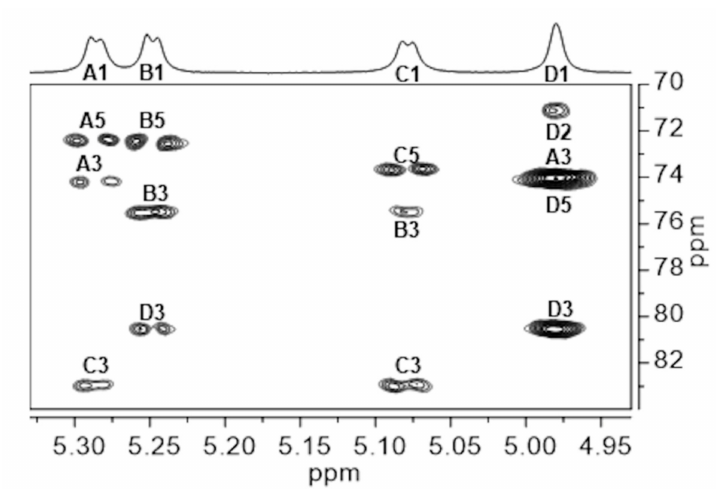
Figure 4. Expansion of the gHMBCAD plot recorded at 50 ◦ C of Epol H111-INS extracted from the biofilm of B. cenocepacia H111. Intra- and inter-residue correlations have been labelled according to the corresponding residue ( A to D ), as in Table